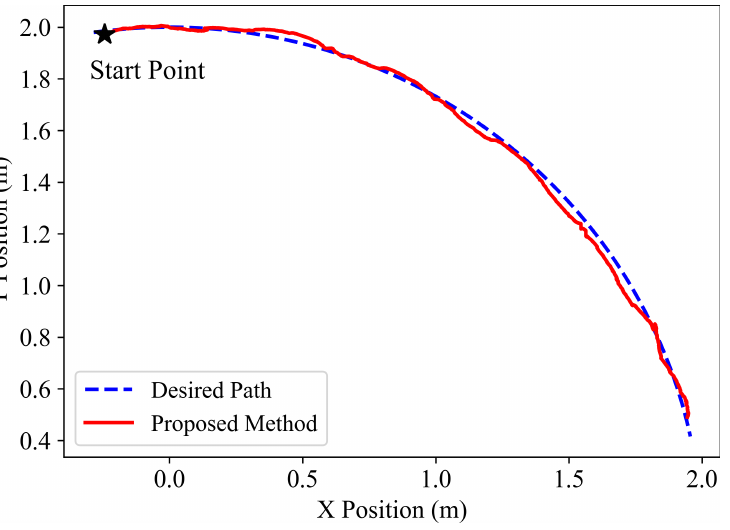
Figure 8. Path following results of the desired circle for the proposed hierarchical